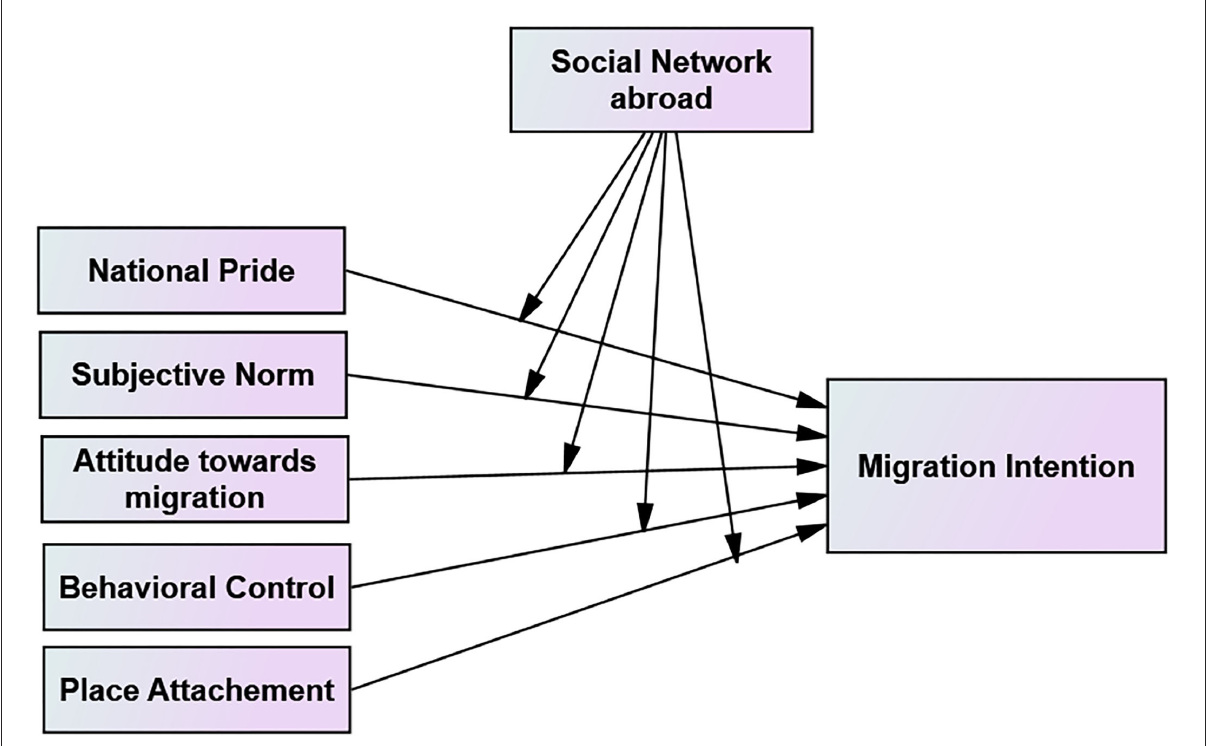
FIGURE1 Conceptual frameworks to test the relationship and moderation effect of the variables.